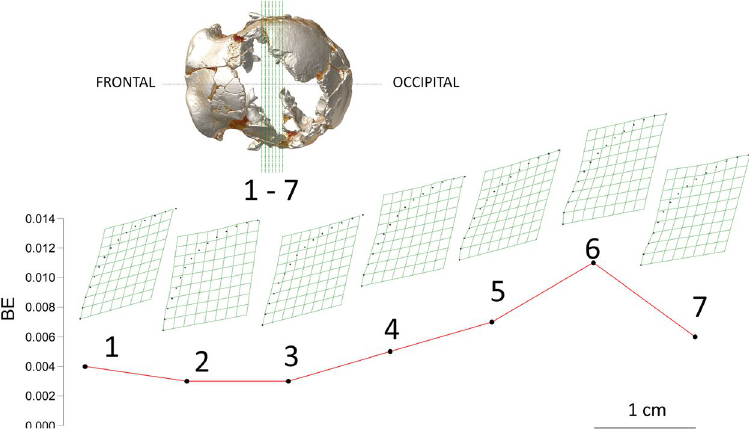
Figure 6. Transformation grids and associated bending energy values obtained after superimposition of the left/right profiles of the external surface of the parietal walls along seven coronal cross sections, equally spaced 1 cm